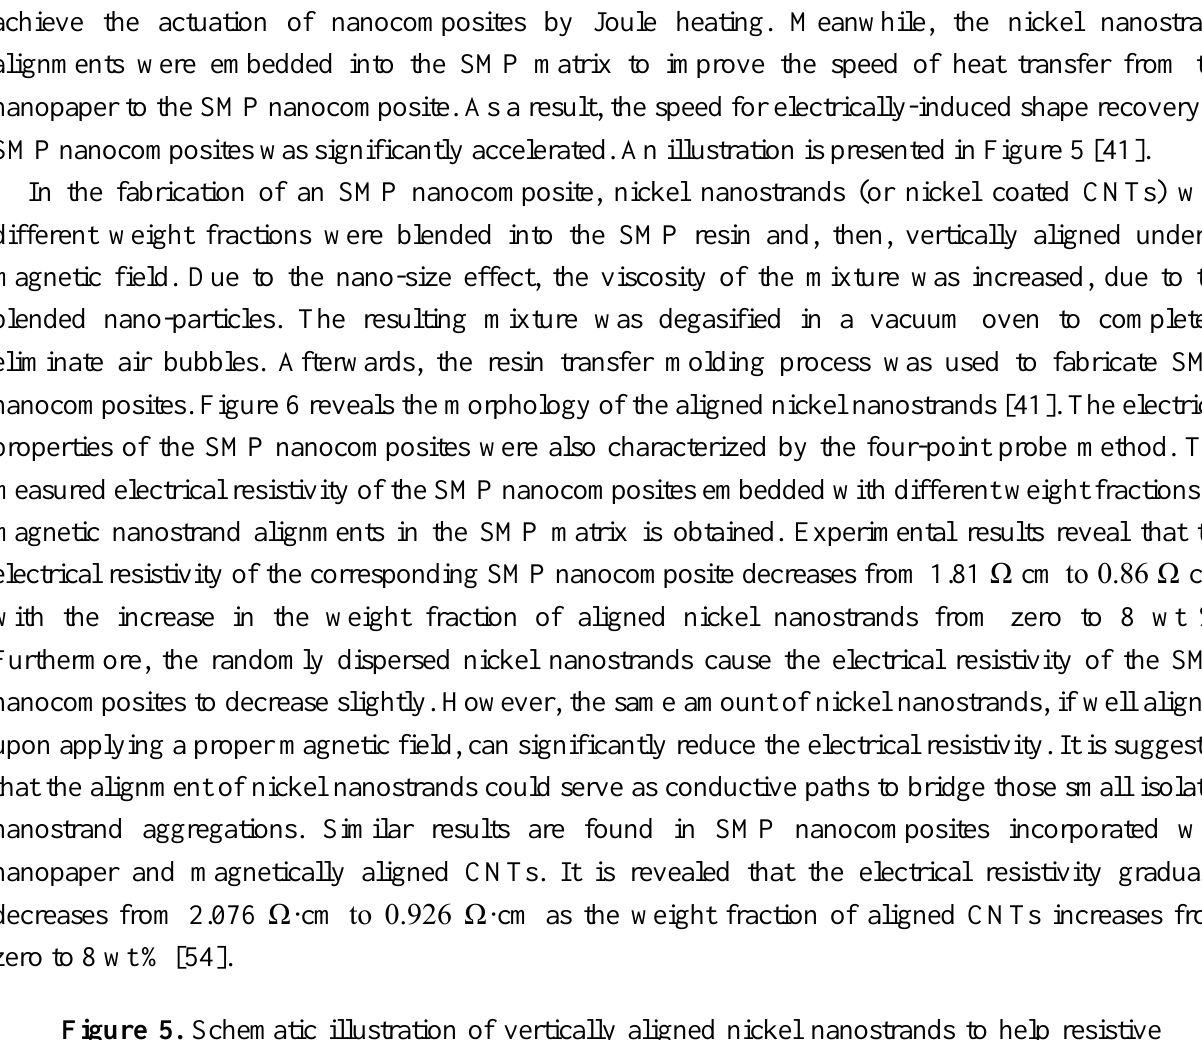
Figure 5. Schematic illustration of vertically aligned nickel nanostrands to help resistive heating power to transfer from the nanopaper to the underlying SMP. Reproduced with permission from [41]. Copyright 2011 RSC